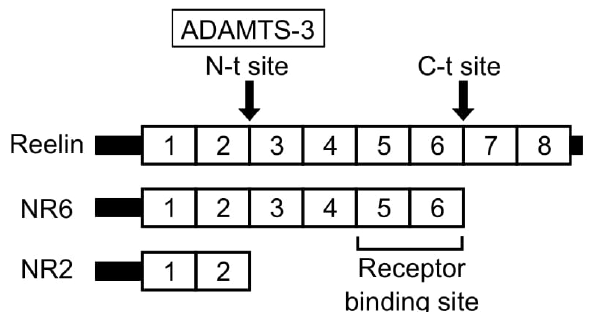
Figure 1. Schematic representation of the Reelin structure and cleavage by a disintegrin and metallo- proteinase with thrombospondin motifs-3 (ADAMTS-3).